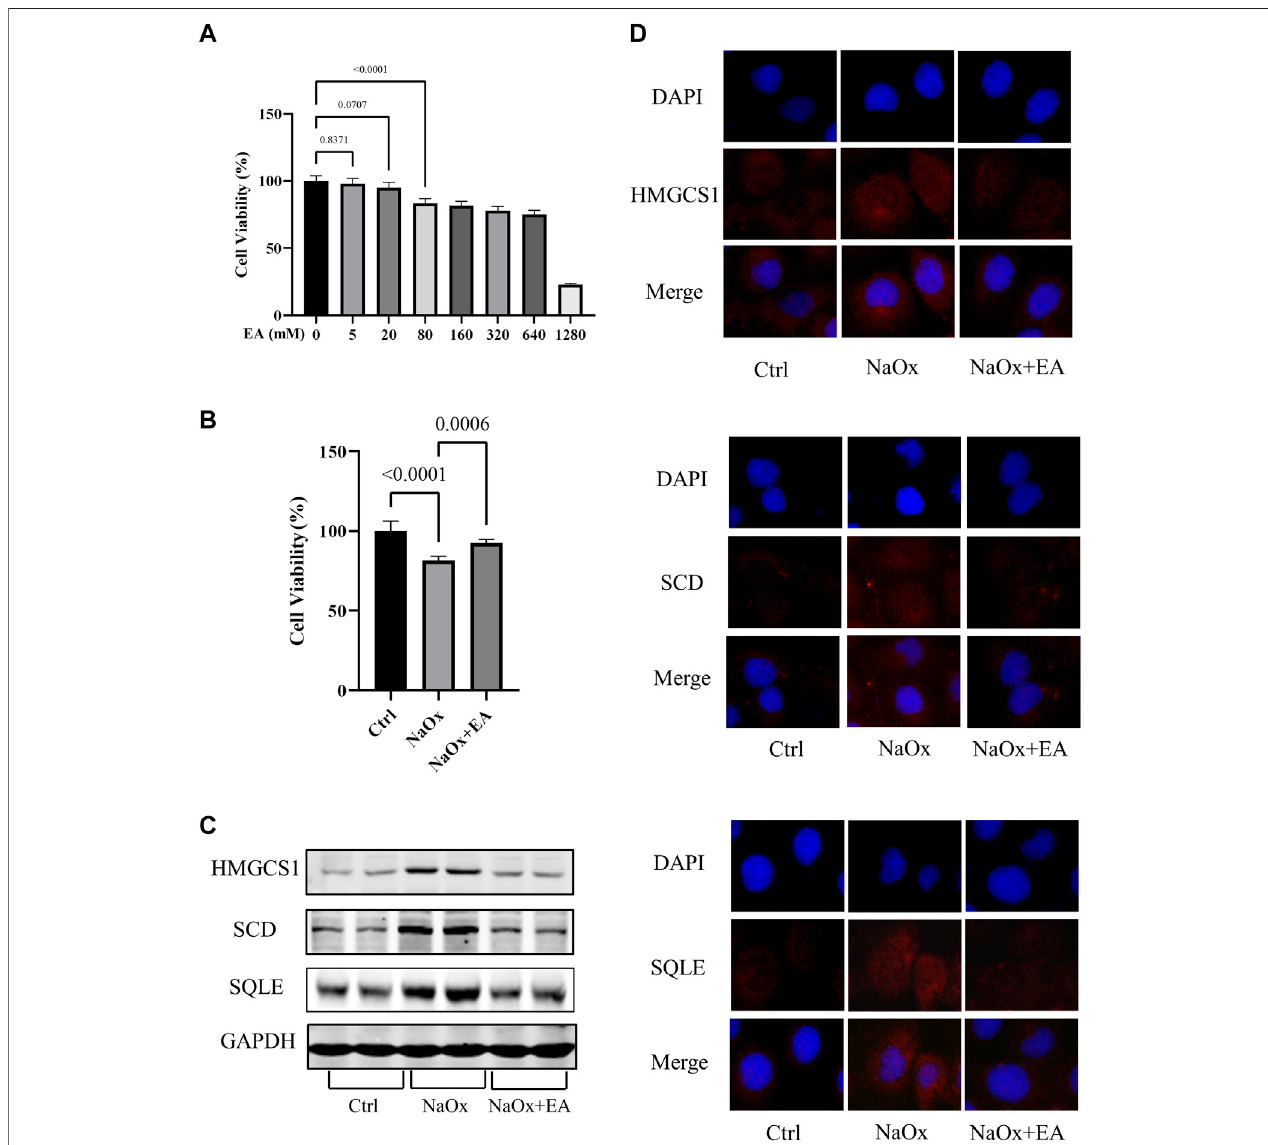
FIGURE4| EllagicacidprotectsNaOx-inducedinjuryincellsandreducestheexpressionofSQLE,HMGCS1, andSCD (A) ThecytotoxicityofellagicacidonHK-2 cells determined by the CCK8 assay (B) The cytotoxicity of ellagic acid on NaOx treated HK-2 cells determined by the CCK8 assay (C) The expression of SQLE, HMGCS1, and SCD by Western blot in the control group (Ctrl), sodium oxalate group (NaOx), and ellagic acid treatment group (NaOx + EA) (D) Cells were analyzed by immunocytochemistry (100X) in the control group (Ctrl), sodium oxalate group (NaOx), and ellagic acid treatment group (NaOx + EA).